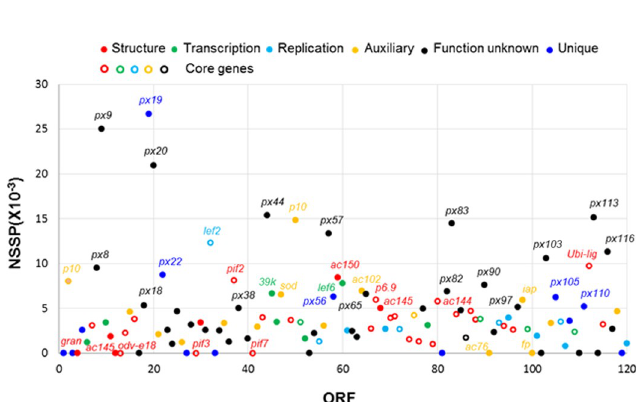
Fig 4. Nonsynonymous variations in ORFs of nine PlxyGV isolates. Scatter plots represent ORFs with their levels of nonsynonymous sequence substitution per base pair (NSS/bp × 10 − 3 ) demonstrated. Red, green, light blue, orange, black and blue colors indicate structure protein, transcription factor, DNA replication factor, auxiliary, function unknown and PlxyGV unique genes, respectively. Hollow circles indicate baculovirus core genes. ORF71, which shows 158 NSS per base pair ( × 10 − 3 ) is not